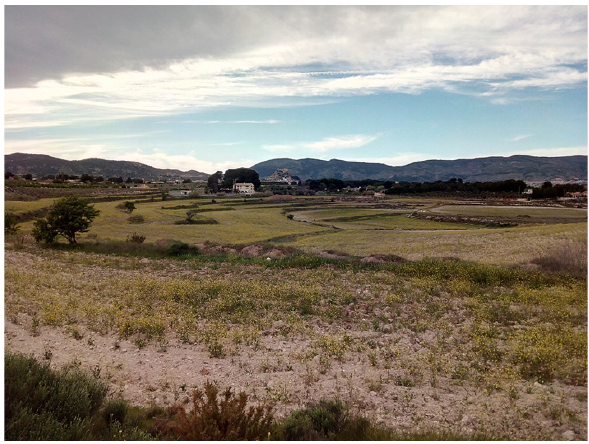
Figure 2. Castalla cultural landscape with